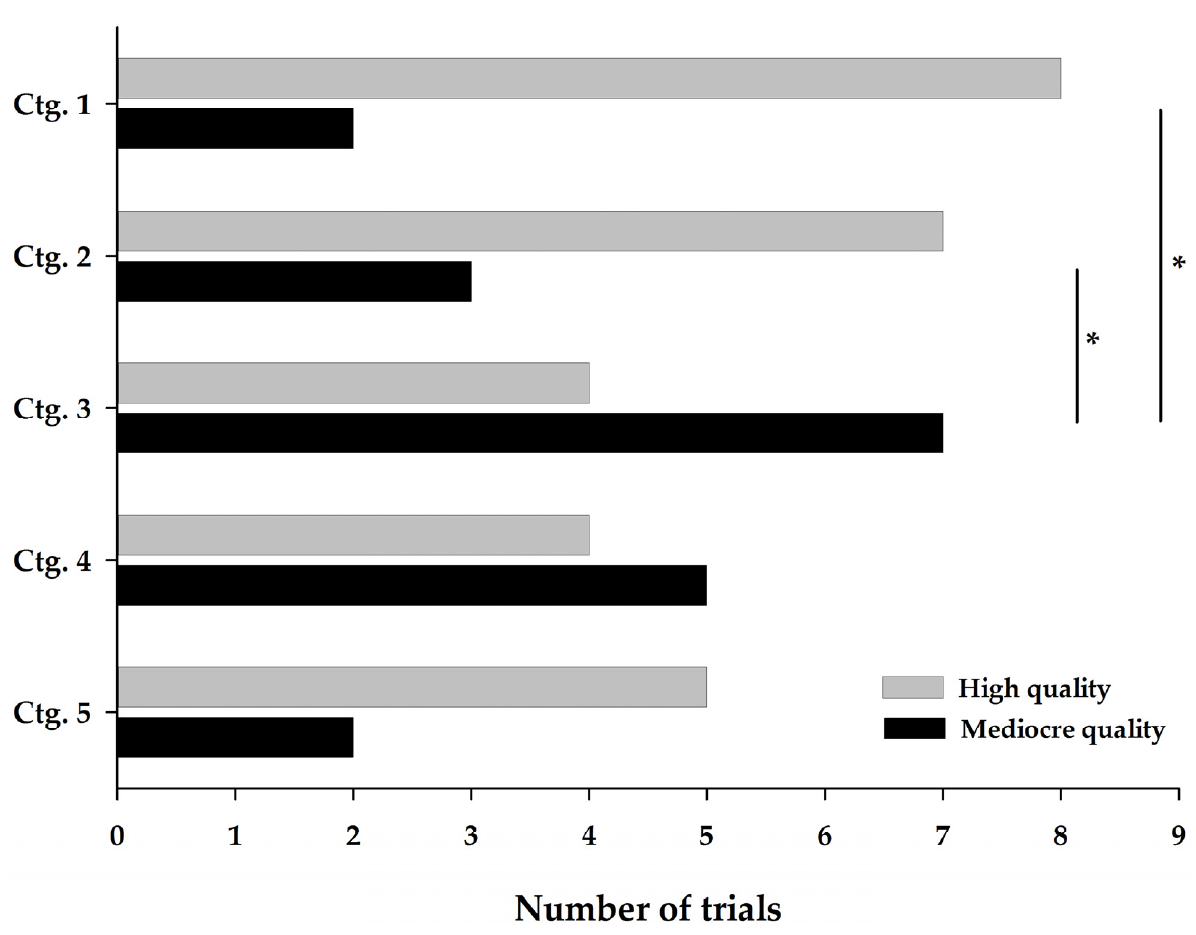
Figure 2. Distribution of quality levels of compound categories 1 to 5. A high-quality trial is represented by levels A and B, while a mediocre-quality trial is represented by levels C and D. Ctg. 1 (omega-3-enriched therapeutic diets), ctg. 2 (omega-3-based nutraceuticals), ctg. 3 (collagen-based nutraceuticals), ctg. 4 (chondroitin-glucosamine-based nutraceuticals) and ctg. 5 (cannabinoid- based nutraceuticals). Ctg., category. * indicates a significant difference ( p < 0.05) between categories.